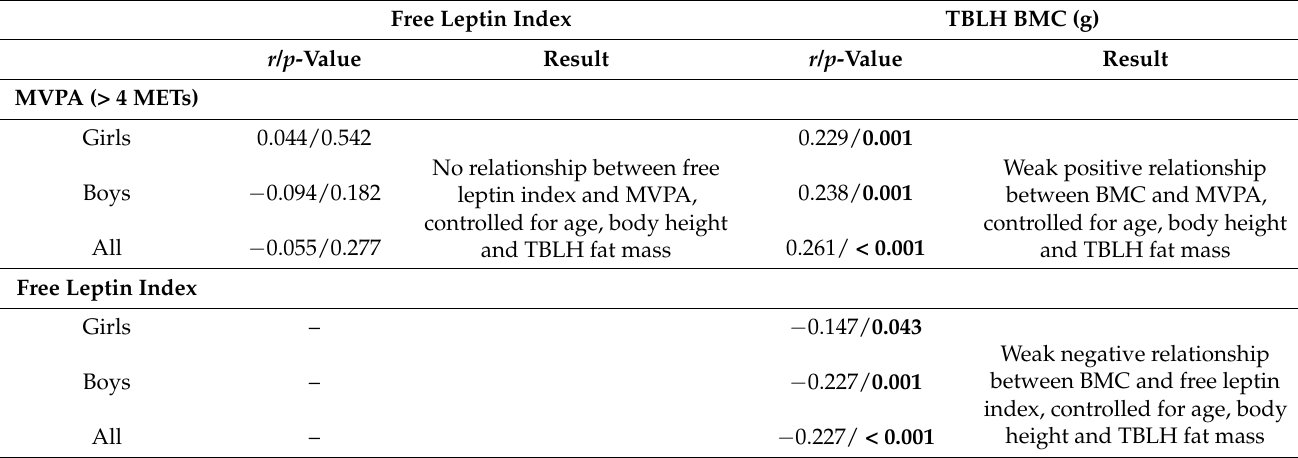
Table 2. Partial correlations of independent, mediator and dependent variables according to